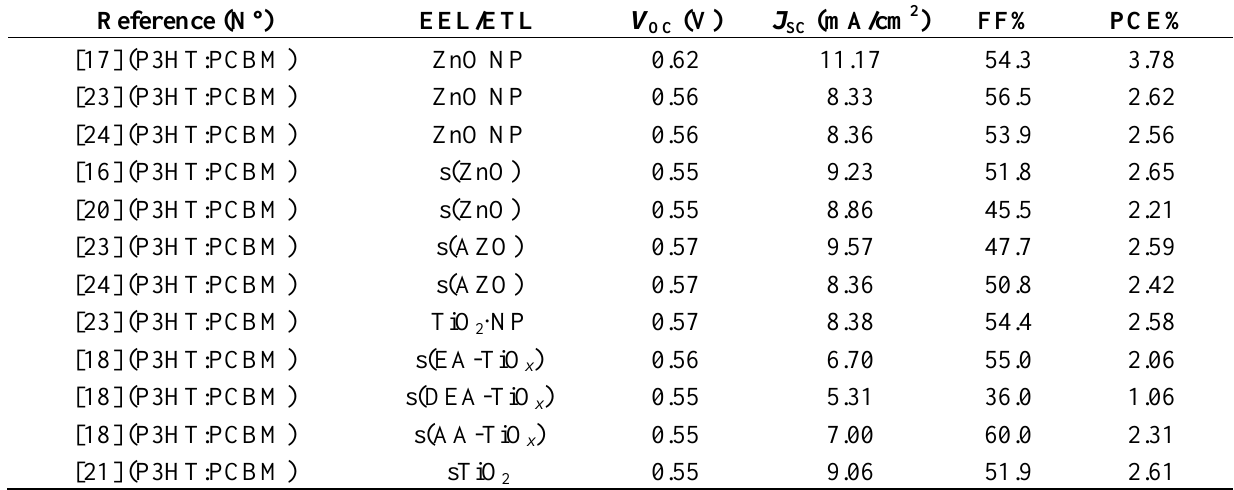
Table 1. Device parameters of i-BHJ solar cells with different electron transport/extraction interlayers. EEL, electron extraction layer; ETL, electron transport layer; V voltage; J , short-circuit current density; FF, fill factor; NP, SC